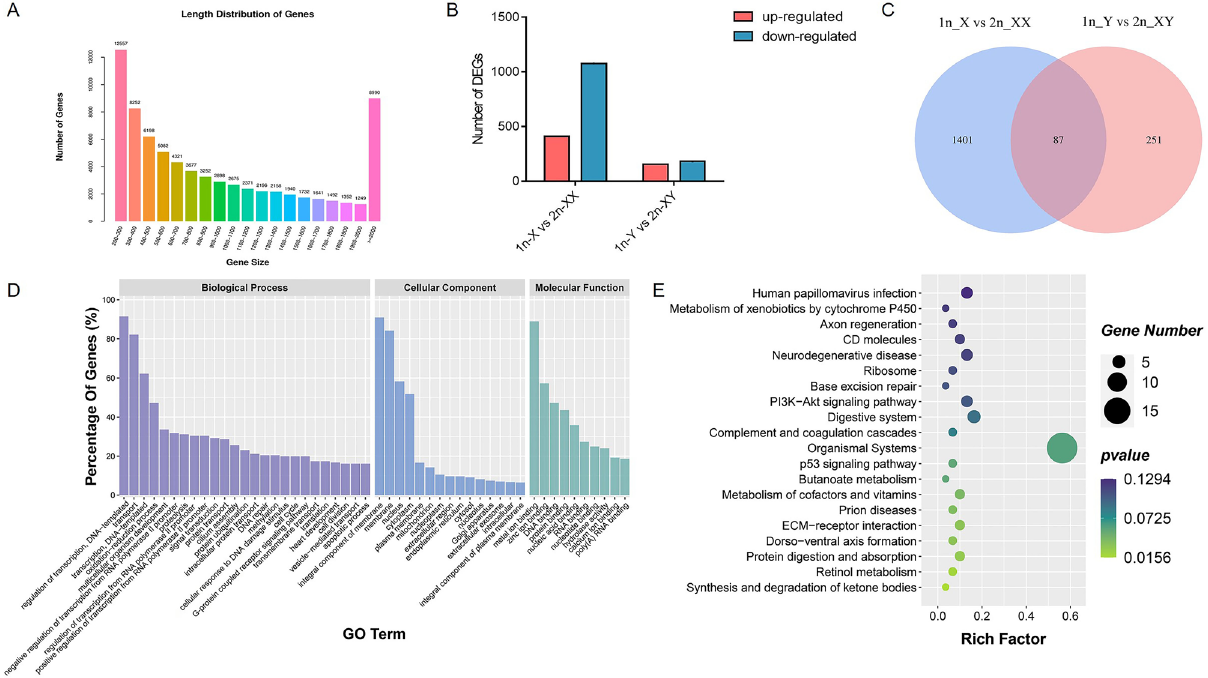
Figure 4. Transcriptome analysis of haploid and diploid tiger pufferfish ( T. rubripes ). ( A ) Length distribution of assembled genes. ( B ) Number of DEGs in 1n-X vs. 2n-XX and 1n-Y vs. 2n-XY comparisons. ( C ) Venn diagram of 1n-X vs. 2n-XX and 1n-Y vs. 2n-XY comparisons. ( D ) GO classification of shared DEGs. ( E ) KEGG enrichment of shared (Table S4). Several DMGs related to genomic stability maintenance and cell cycle changed the methylation levels between haploids and diploids. For example, slf1 and actr8 were hyper-methylated in haploid females and males. gas2 and pbrm1 were hypo-methylated in haploid females and males. The validation of the DMG data was con- ducted on the four genes, and the results were in agreement with the WGBS data ( R 2 = 0.974. p < 0.001) (Fig. S3). Transcriptome sequencing and assembly.